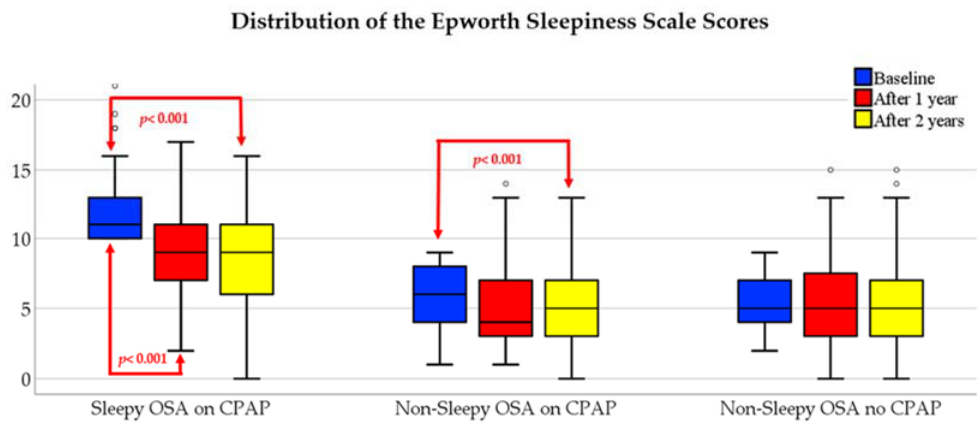
Figure 3. Changes in the Epworth Sleepiness Scale scores over time in the study population. CPAP, continuous positive airway pressure; OSA, obstructive sleep apnea.